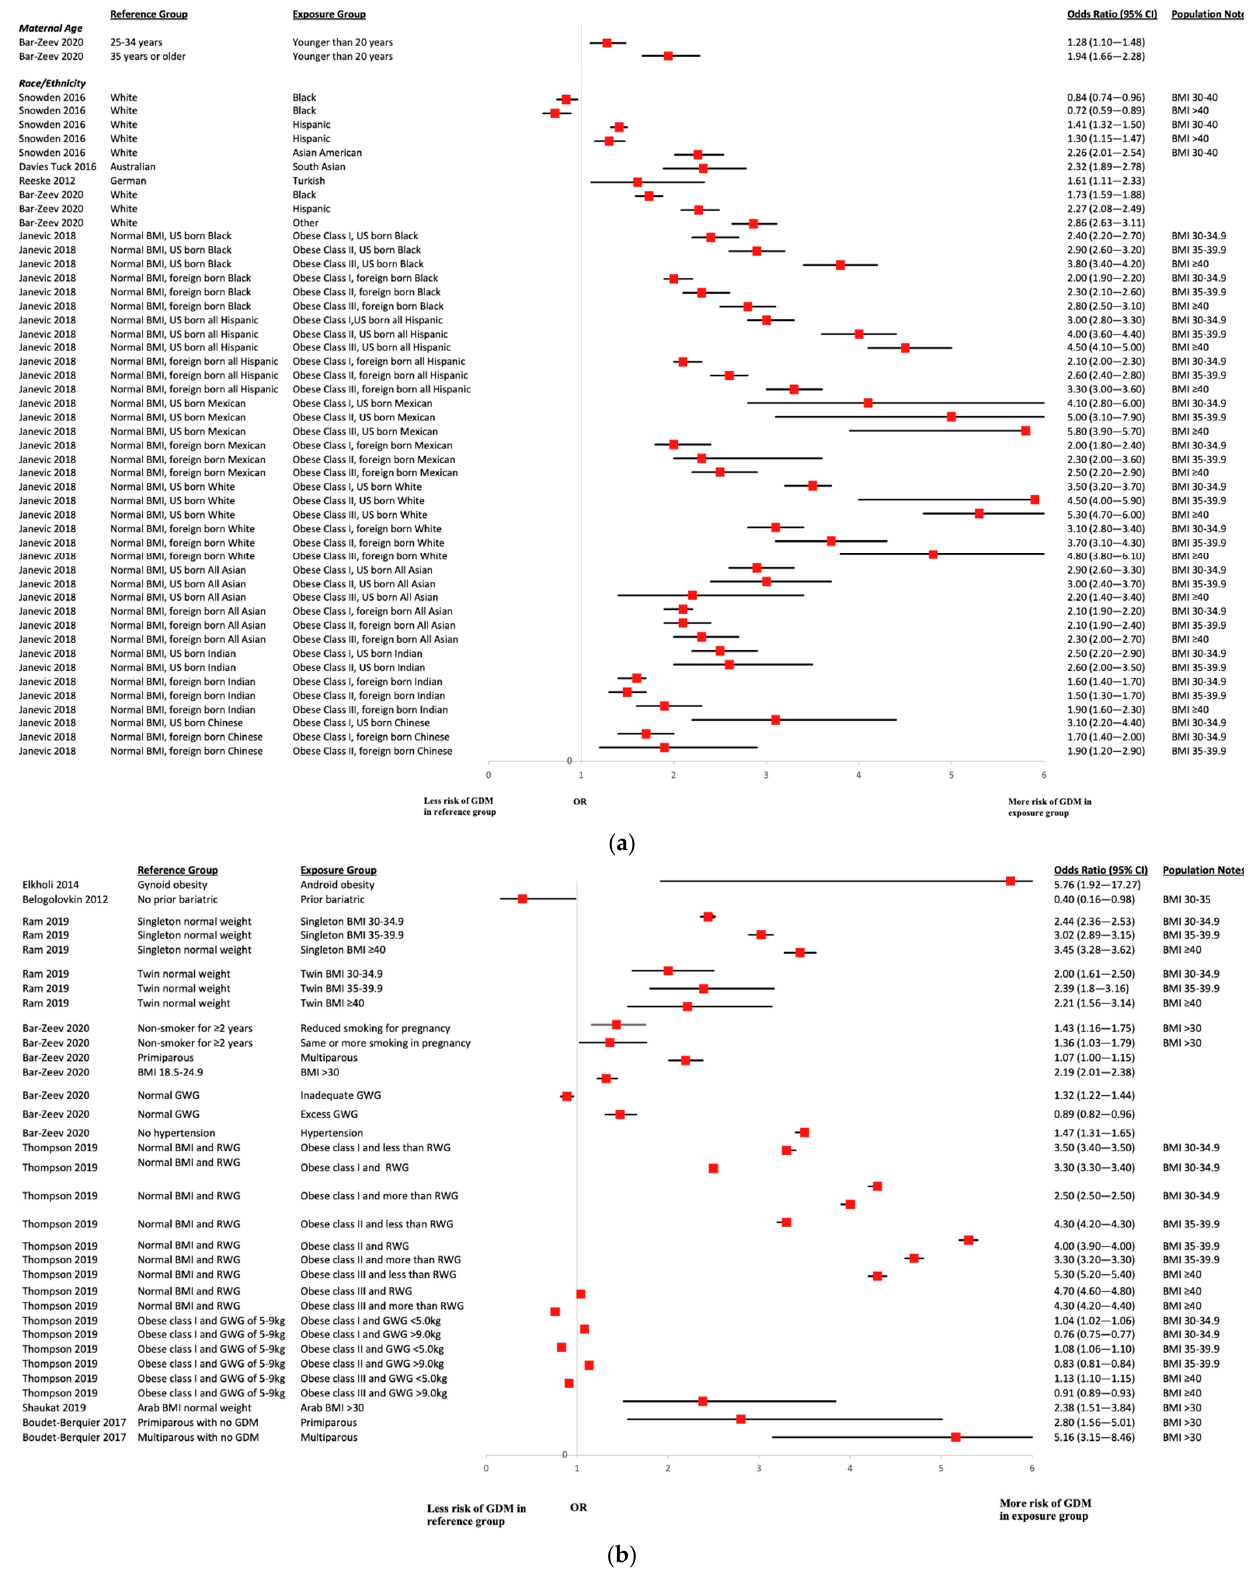
Figure 6. ( a ) GDM Age and Race. Acronyms: BMI = body mass index; US = United States; CI = confidence interval. ( b ) GDM Risk Factors. Acronyms: BMI = body mass index; RWG = recommended weight gain; GWG = gestational weight gain; GDM = gestational diabetes mellitus; CI = confidence